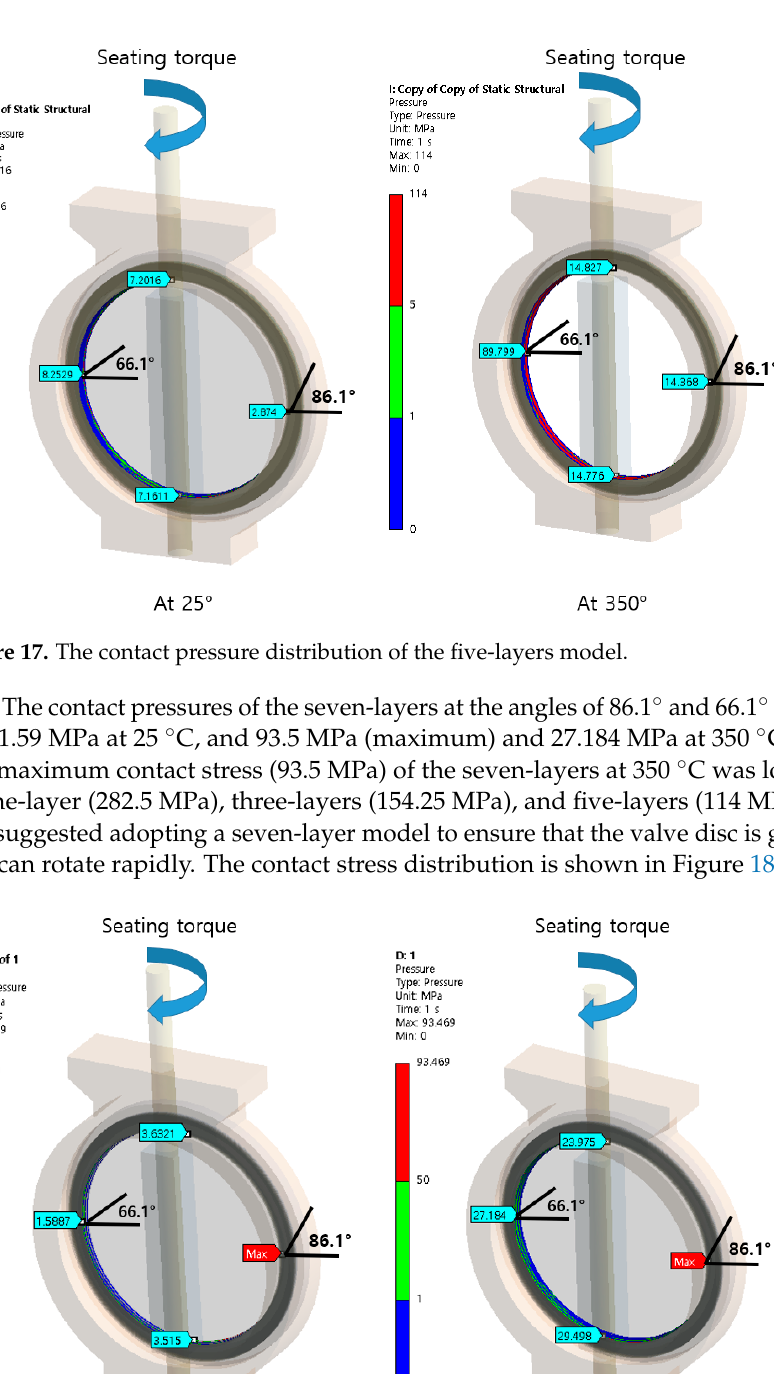
Figure 16. The contact pressure distribution of the three-layers model.